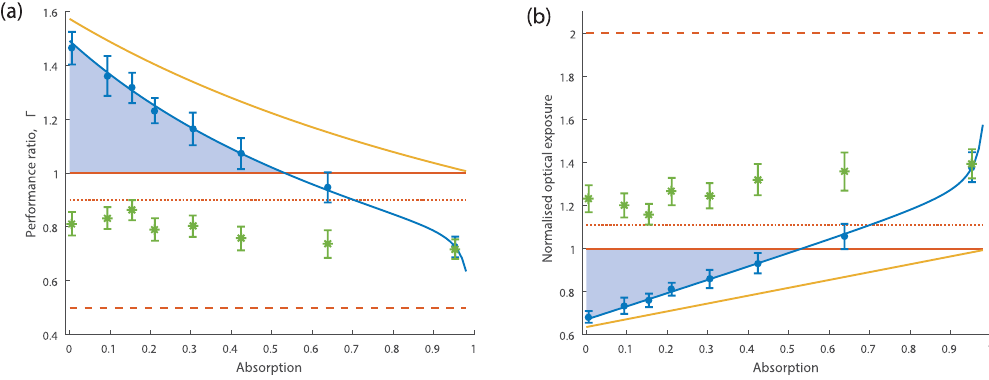
Figure 4. Absolute quantum advantage in absorption measurement. ( a ) Γ is the ratio of the variance of an absorption estimate for the ideal classical scheme, to our experimental measurement. ( b ) Normalised optical exposure for equal precision, computed from the ratio between the number of photons probing the sample in a particular scheme and in the best direct classical scheme attaining the same estimation precision by increasing the illumination. In both plots: the red solid lines correspond to the ideal classical limit, the red dotted lines correspond to a classical state detected with the same 90% efficiency as in our setup, and the red dashed lines correspond to the example of a differential classical measurement where a laser is split on a 50:50 beamsplitter (Fig. 1(b)) and therefore quantum fluctuations are un-correlated. The yellow line corresponds to the theoretical limit achievable by our system, taking into account the measured rate of classical fluctuations and the arms efficiencies (See Supplementary material). The blue dots with error bars correspond to the experimental data using the quantum corrected measurement. The green asterisks correspond a classical measurement with our setup, using only the single photons generated from downconversion passing through the sample in Arm 1 and ignoring any correlated data in Arm 2. And finally the blue shadowed area highlight the absolute quantum advantage that is detected. Error bars correspond to the standard error on the related quantities taking into account both the uncertainty on the precision of the measurement and the uncertainty on the efficiency of the camera following error propagation on equations (3) and (4). The blue lines correspond to best-fit to the theory, with extra parameters corresponding to eventual super-poissonian non-deterministic and deterministic noise in each fluorescence beam, and to camera noise. All data and curves in both plots normalise to PPE to the sample. N.b. the first point of each plot is obtained with only the HWP as a sample i.e. removing the